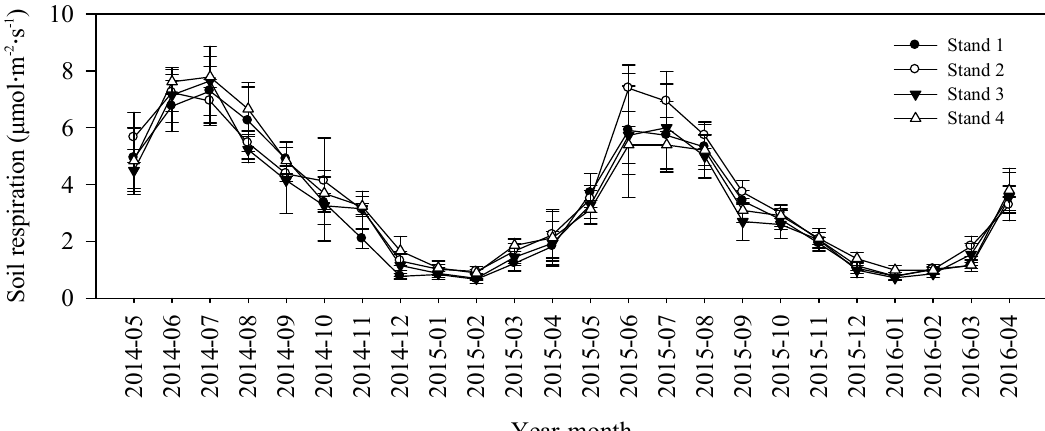
Figure 5. Soil respiration rates monthly dynamic between May 2014 and April 2016 in four moso bamboo stands. The error